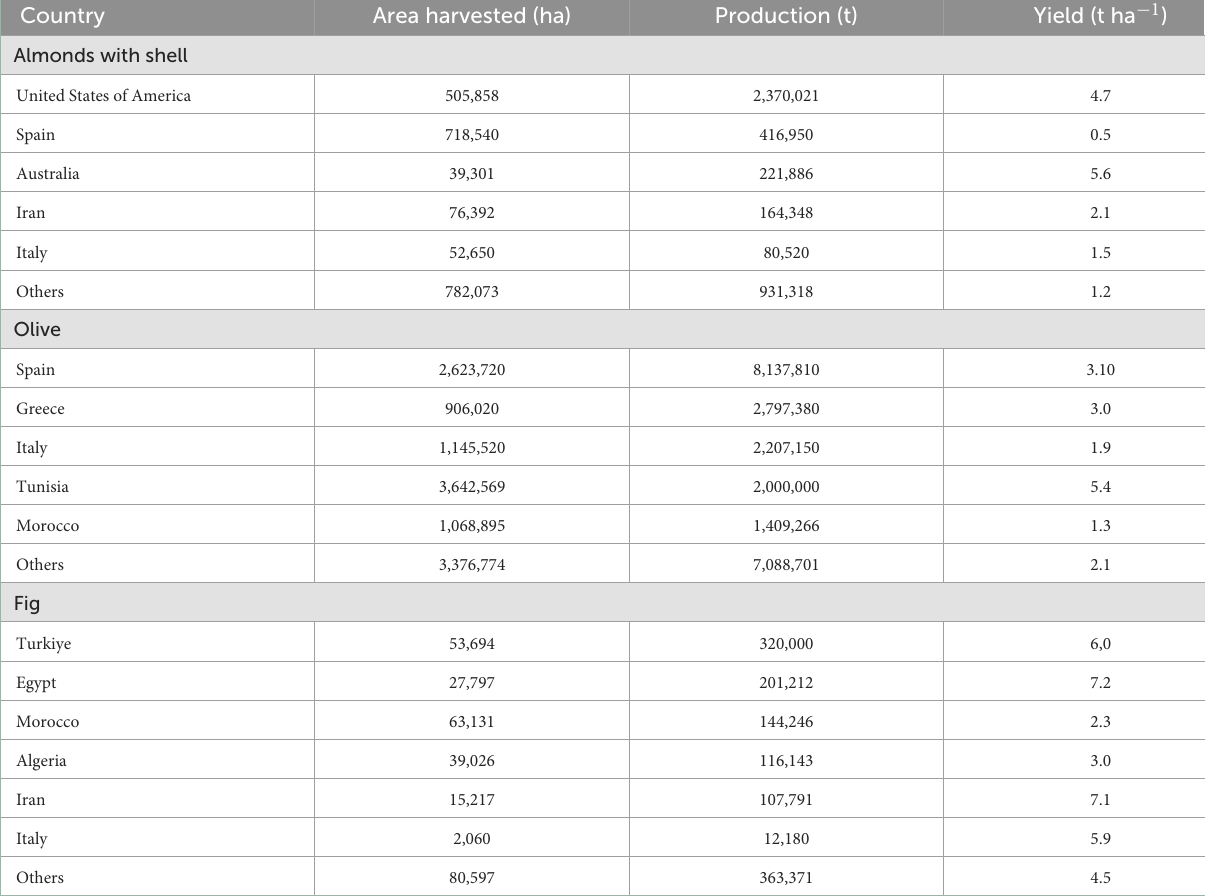
TABLE 1 Production and area harvested of almond, olive, and fig around the world. Country Area harvested